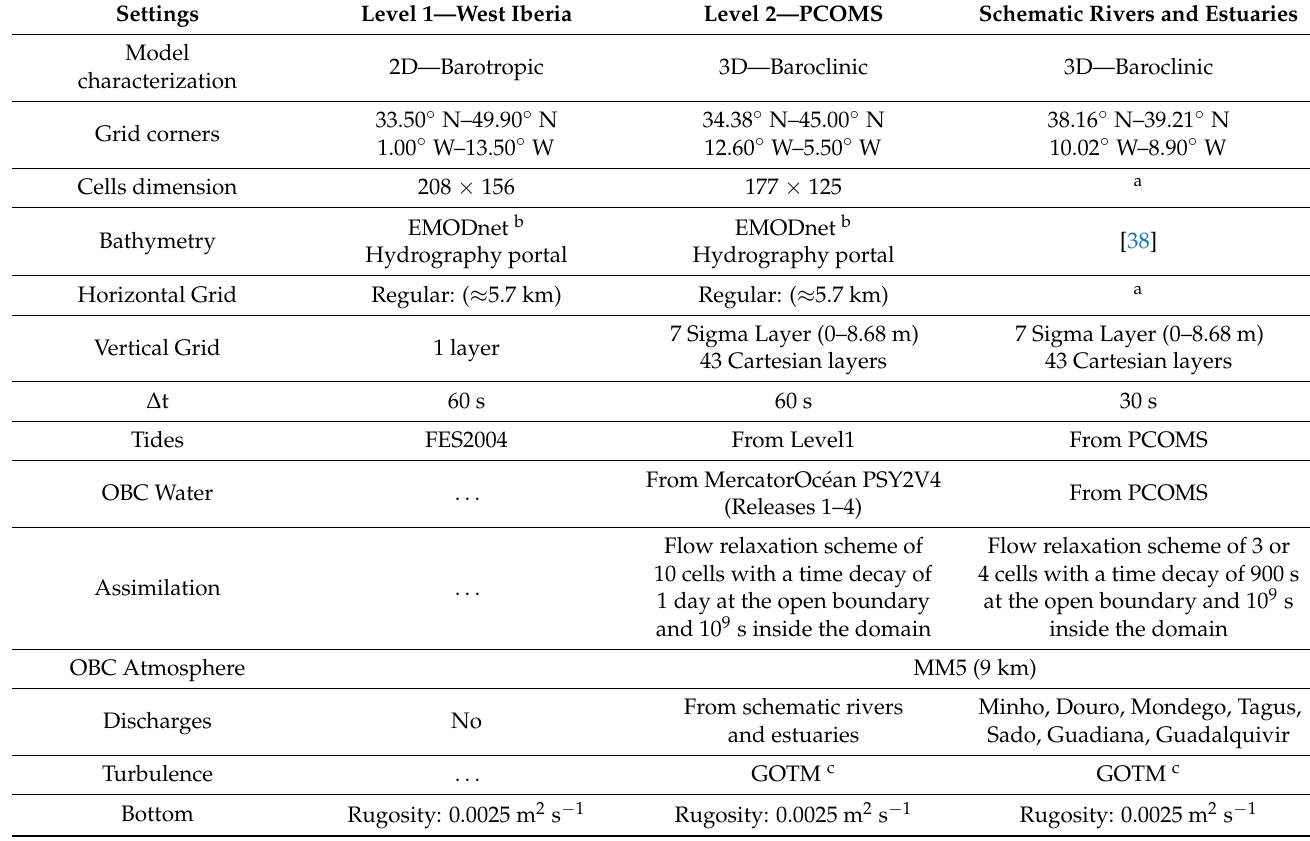
Table 2. Model setup configuration for the TagusROFI